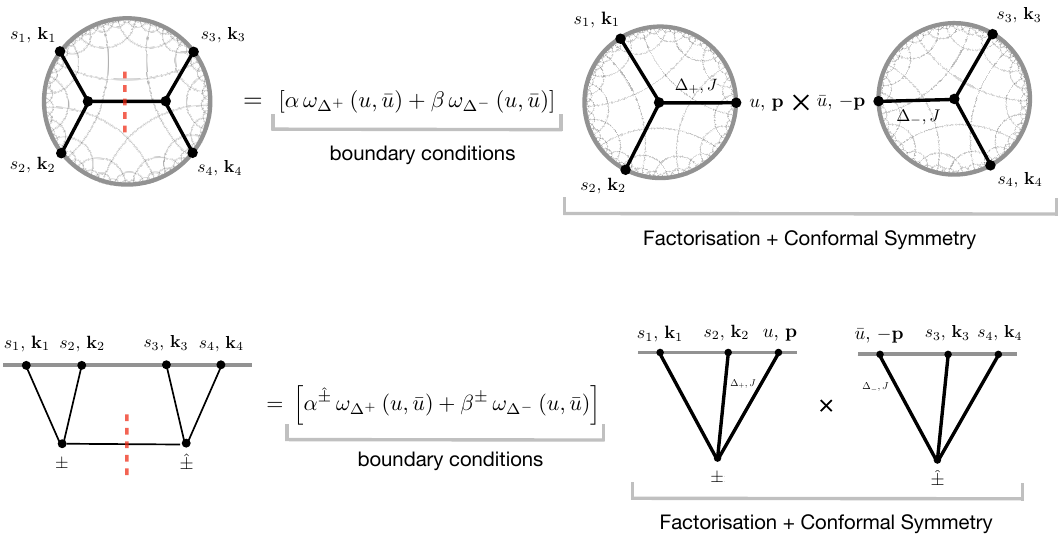
Figure 17. Exchanges both in EAdS and dS are determined by a combination of factorisation + conformal symmetry (which is ensured by an appropriately normalised conformal partial wave (4.12)) and boundary conditions which is implemented in the Mellin-Barnes representation by the projectors ω ( u, ¯ u ) ∆ ±